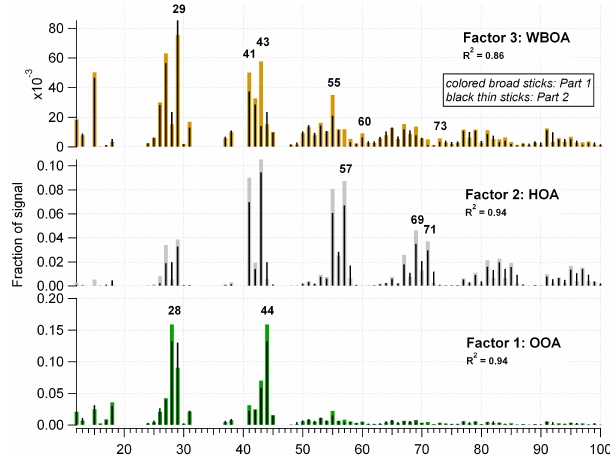
Figure 3: Normalized mass spectral signatures of factors 1 (OOA), 2 (HOA), 3 (WBOA) of the chosen 2 Fig. 3. Normalized mass spectral signatures of factors 1 (OOA), 2 PMF solution. Colored sticks and black sticks denote results for part 1 and 2, respectively. R 2 values 3 (HOA), 3 (WBOA) of the chosen PMF solution. Colored sticks and quantify similarity of spectra from part 1 and 2. 4 black sticks denote results for part 1 and 2, respectively. R 2 values quantify similarity of spectra from part 1 and